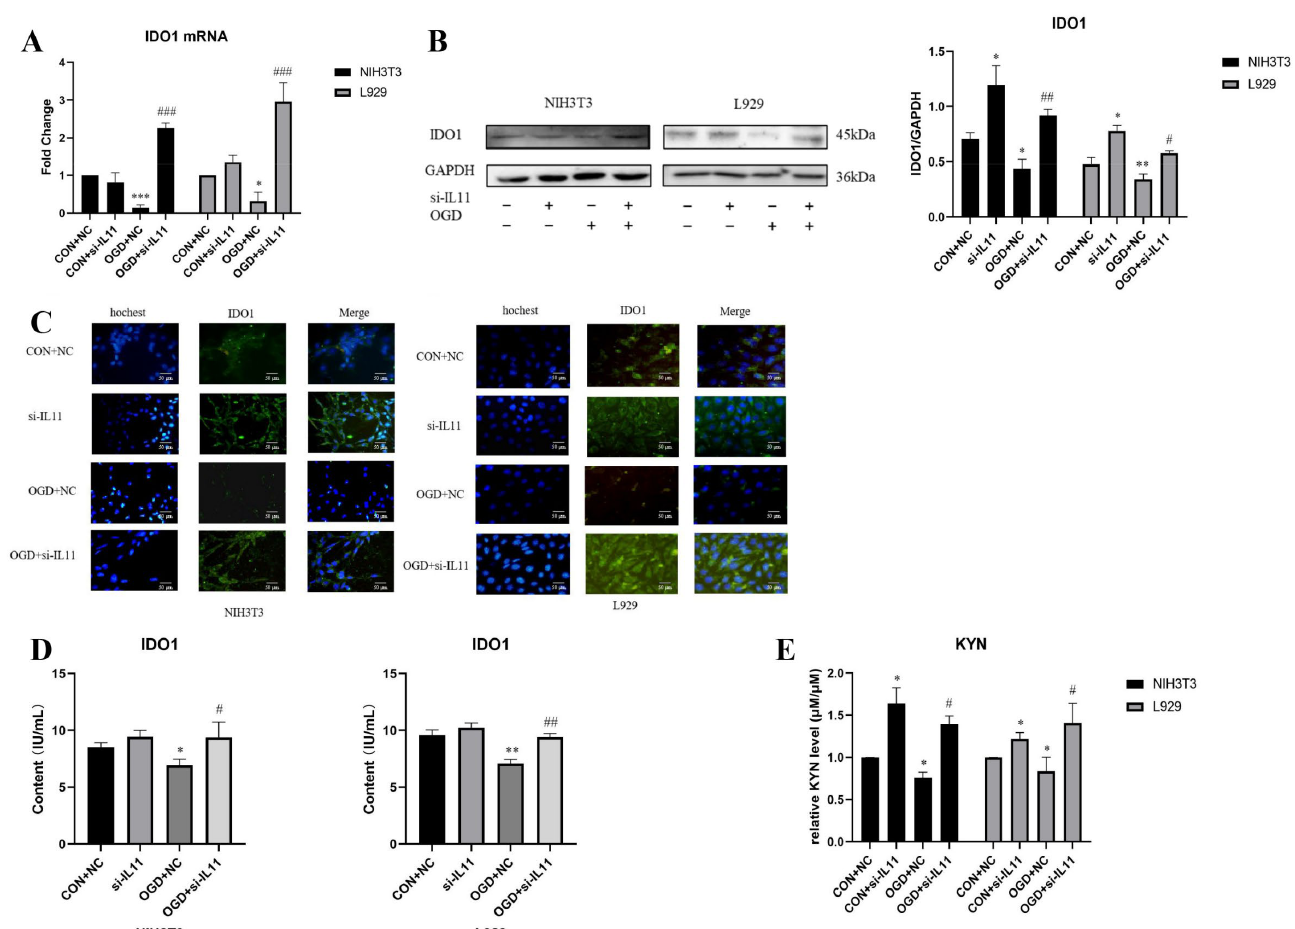
Figure 8. Interfering with IL11 promoted the expression of IDO1. ( A ) mRNA expression was estimated by RT-PCR for IDO1 after inhibiting IL11 in NIH3T3 and L929 cells. ( B ) Western blot analysis and densitometric analysis of IDO1 protein levels after inhibiting IL11 in NIH3T3 and L929 cells; GAPDH was used as the loading control. ( C ) Representative immunocytochemistry staining of IDO1 and cell nuclei (Hoechst) after inhibiting IL11 in NIH3T3 and L929 cells. ( D ) IDO1 content estimated by ELISA from treated cell lysate. ( E ) The relative KYN level was detected by Ehrlich assay after inhibiting IL11 in NIH3T3 and L929 cells. OGD+NC—oxygen–glucose deprivation + negative control; CON+NC—control + negative control. The results are presented as the means ± SDs, and Student’s t-test was used to determine the p -value. * p < 0.05, ** p < 0.01, and *** p < 0.001compared with CON+NC group; # p < 0.05, ## p < 0.01, and ### p < 0.001, compared with OGD+NC